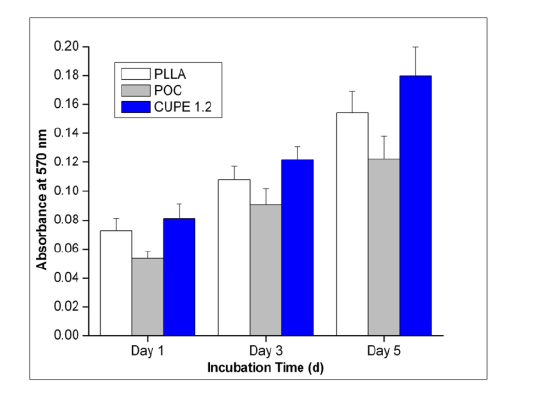
Figure 5. A comparison of 3T3 fibroblast growth and proliferation on single PLLA, POC, and CUPE 1.2 scaffold sheets over a 5-day incubation time period. MTT absorption was measured at 570 nm. N =